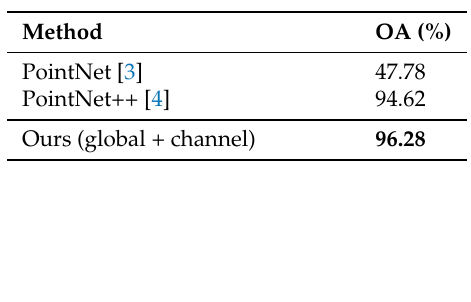
Table 4. Classification results on the ECT